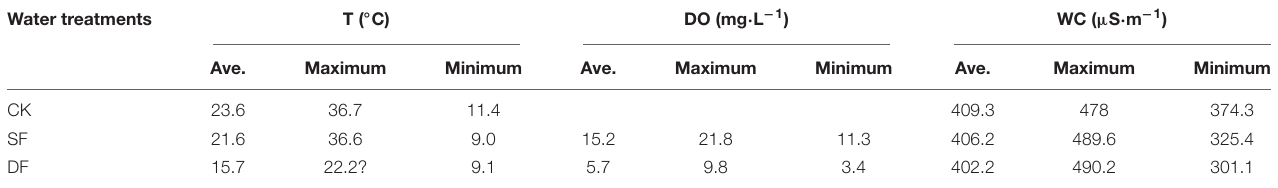
TABLE 1 | The average, maximum, and minimum of air temperature, water temperature, dissolved oxygen, and water conductivity during the experimental period. Water